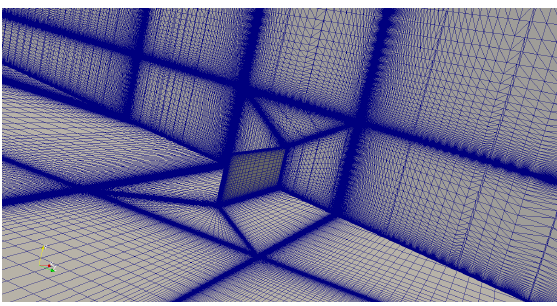
Figure 1. Computational domain.